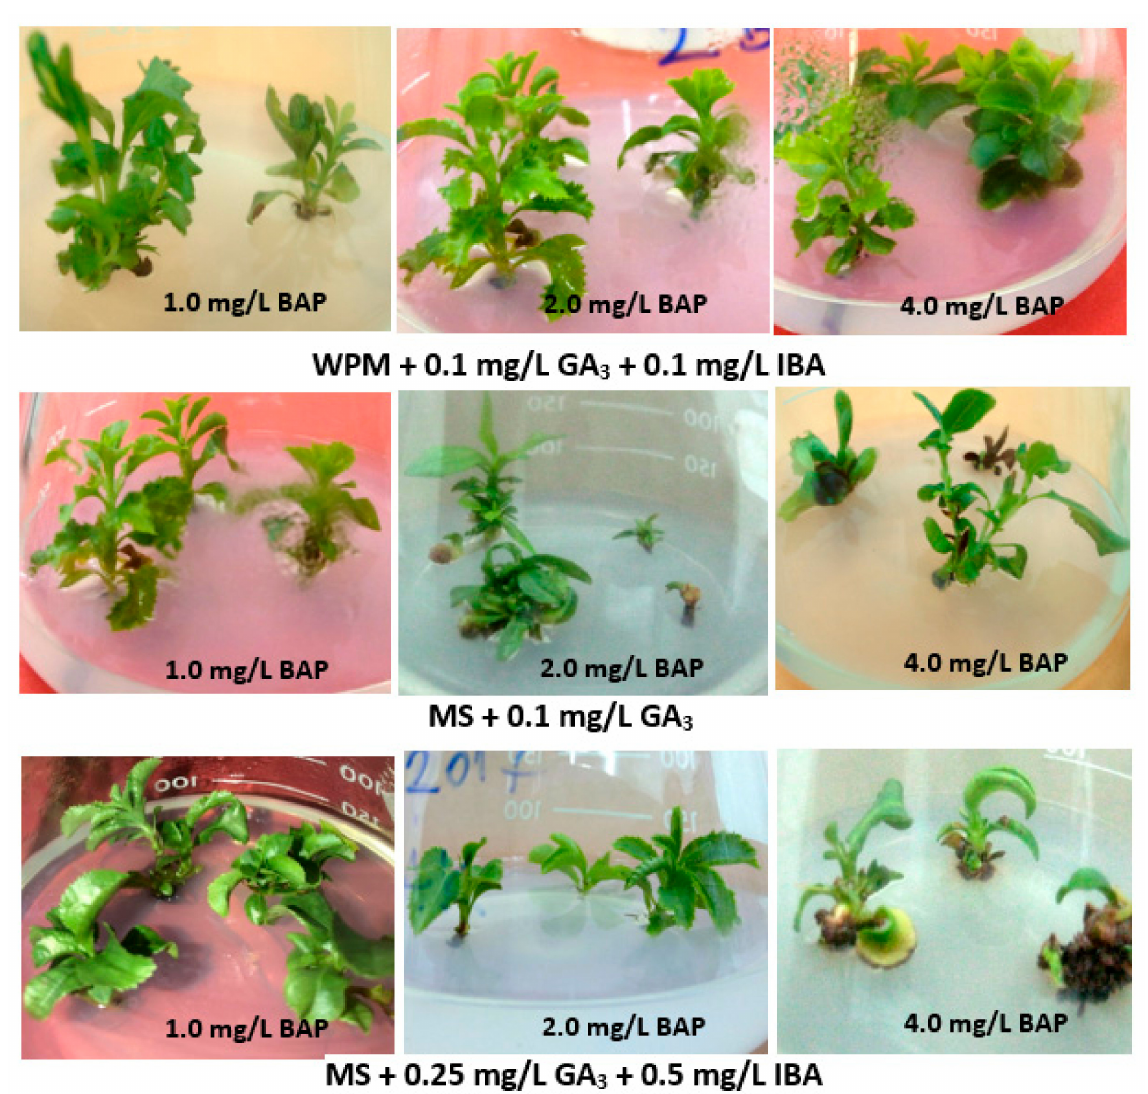
Figure 4. Proliferation stage of YV2 genotype in WPM and MS media supplemented with different growth regulators as